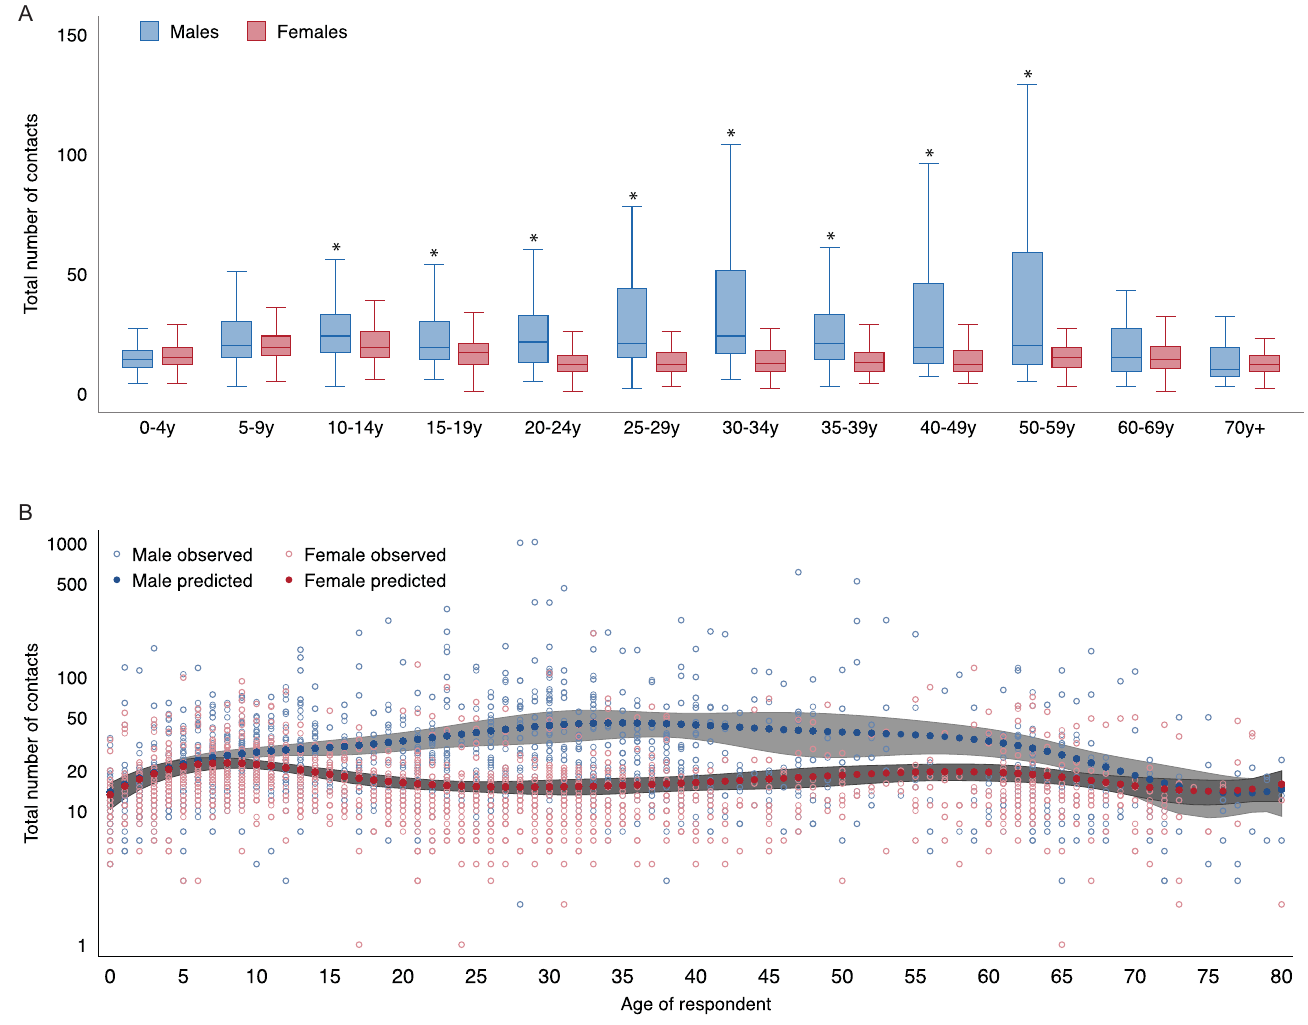
Fig 4. Box plot of total number of contacts by gender and age. Outliers not shown. � signifies a significant difference in the distribution of contact numbers between males and females of the particular age category (A). Observed (open circles) and predicted (filled circles) number of contacts from univariate regression models stratified by gender (male: blue, and female: red), with age splines as predictor variables (B).